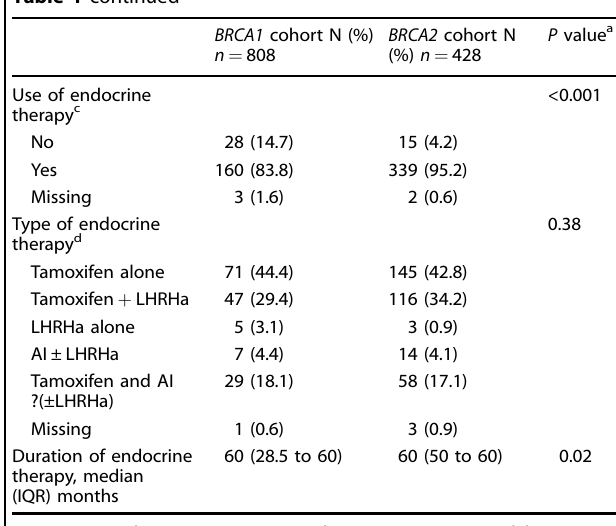
Table 1. Patient, tumor and treatment